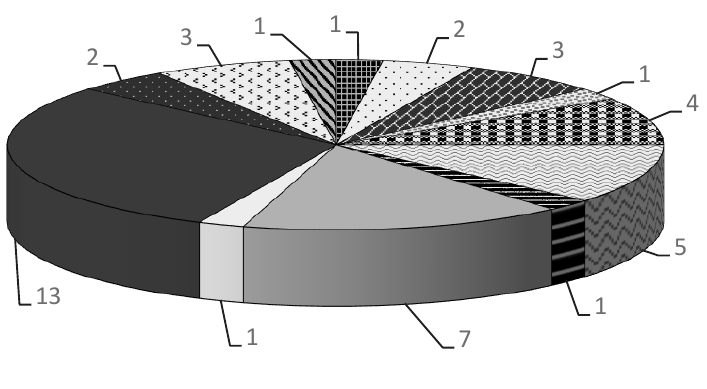
Figure 2. Investment projects in Ukraine by regions,